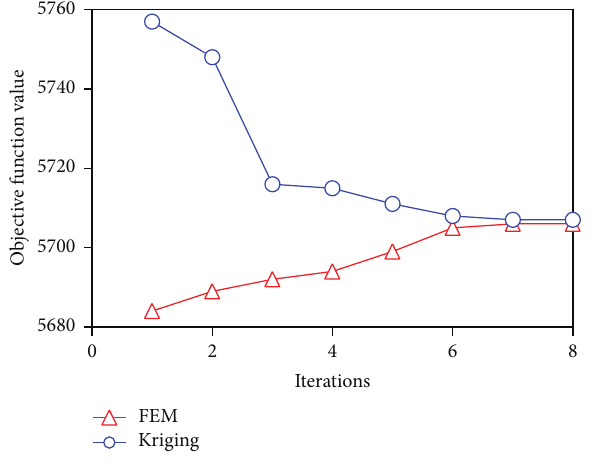
Figure 5: Iterative optimized process.